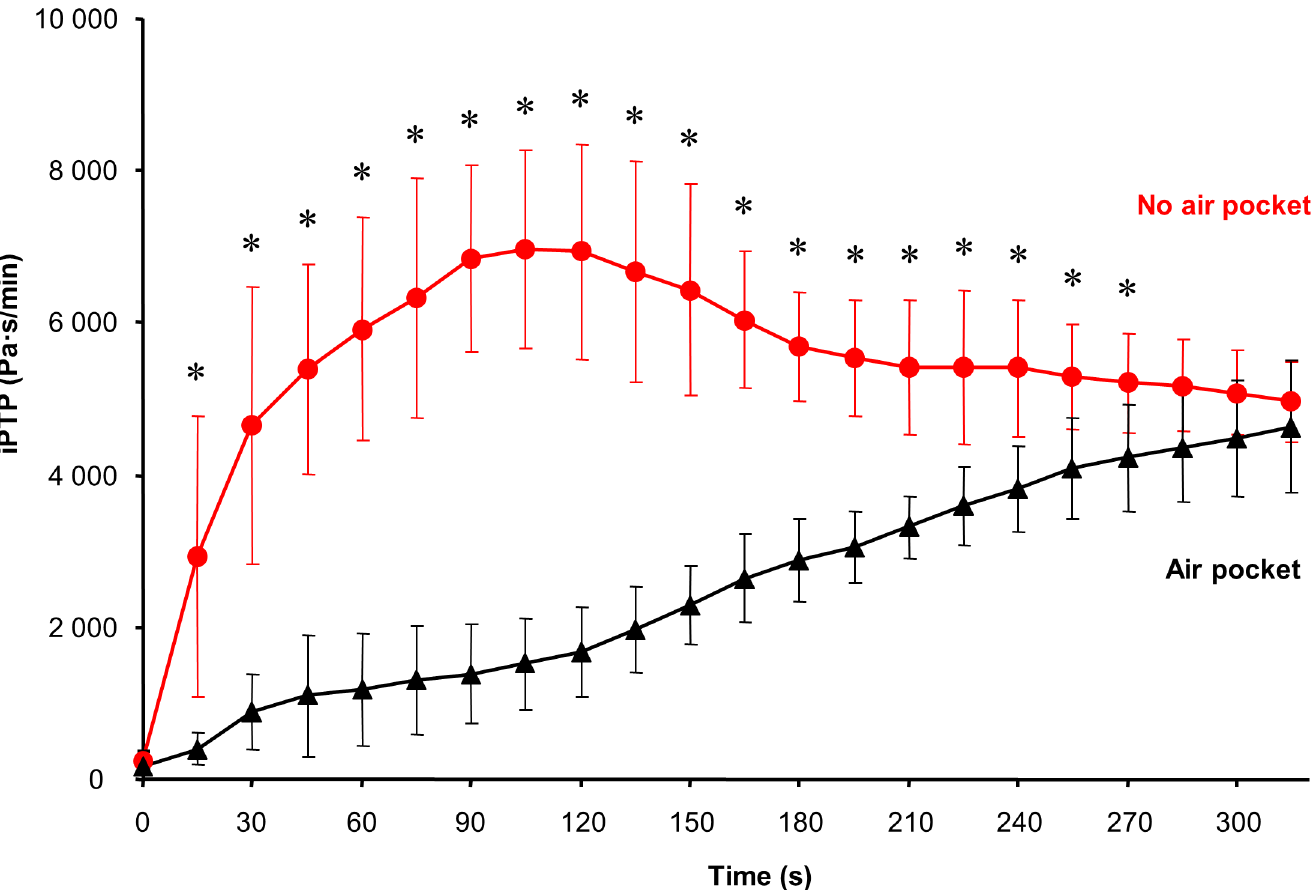
Fig 7. The difference in breathing effort expressed as imposed Pressure-Time Product (iPTP) caused by the flow resistance of snow between no air pocket and one liter air pocket. The symbol * represents the statistical significant differences described by p (cid:1)